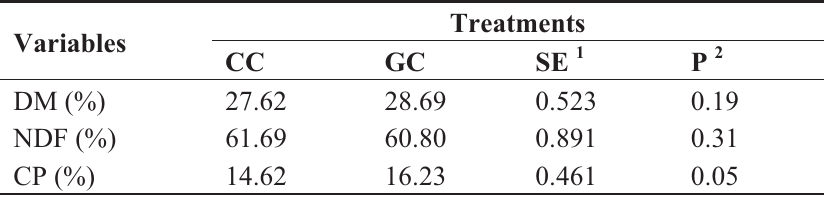
Table 3. Dry matter (DM), crude protein (CP) and Neutral Detergent Fiber (NDF) concentrations in pasture samples collected by the grazing simulation technique with cows fed either commercial concentrate (CC) or ground corn (GC).